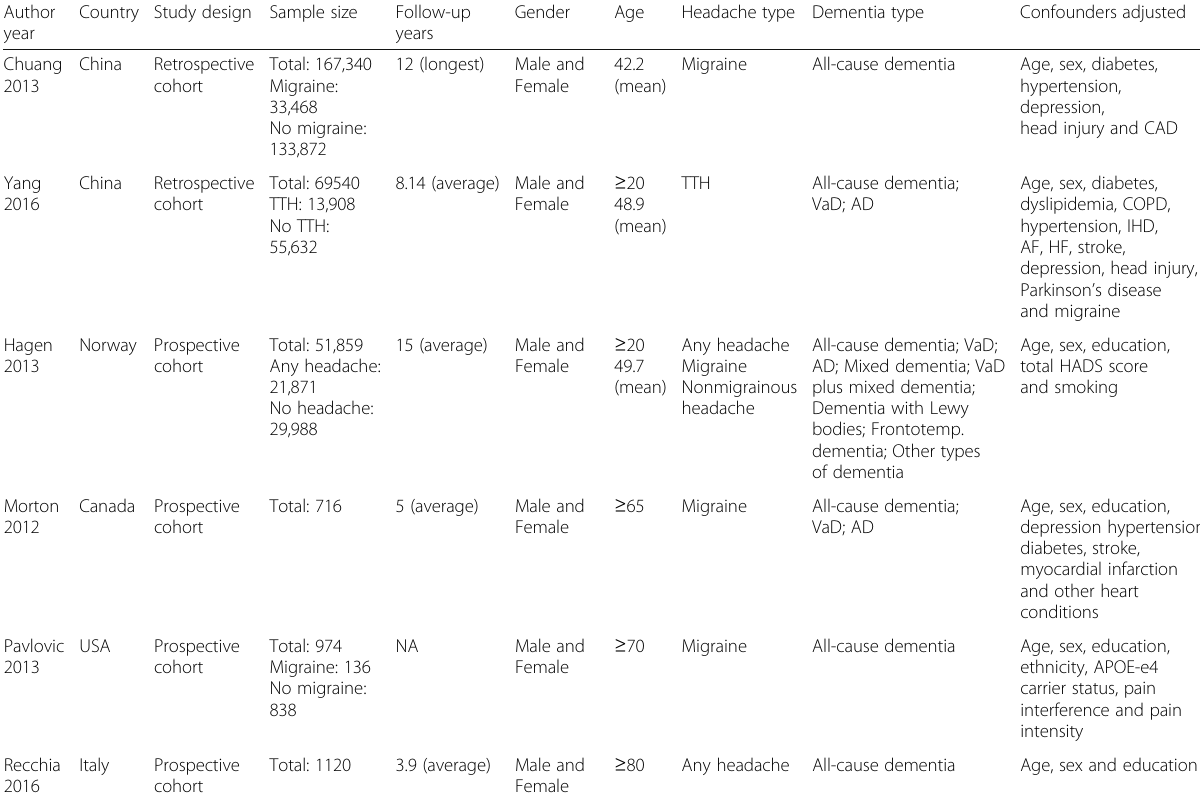
Table 1 The characteristics of included cohort studies in this